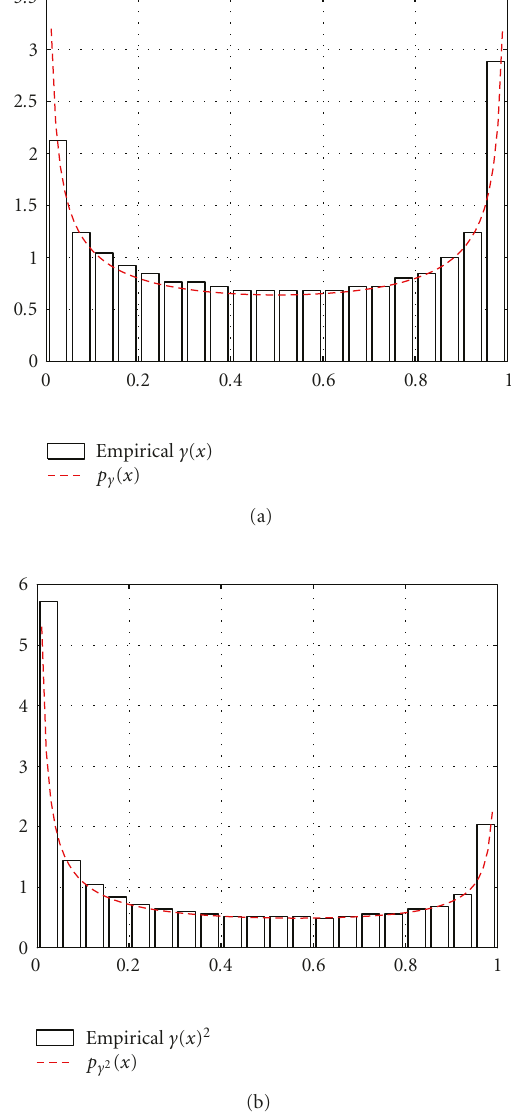
Figure 8: Comparison between the empirical and theoretical pdf’s of (a) γ ( τ ) and (b) γ ( τ ) 2 for the cosine approximation case. To com- pute the histogram N = 5000 samples were